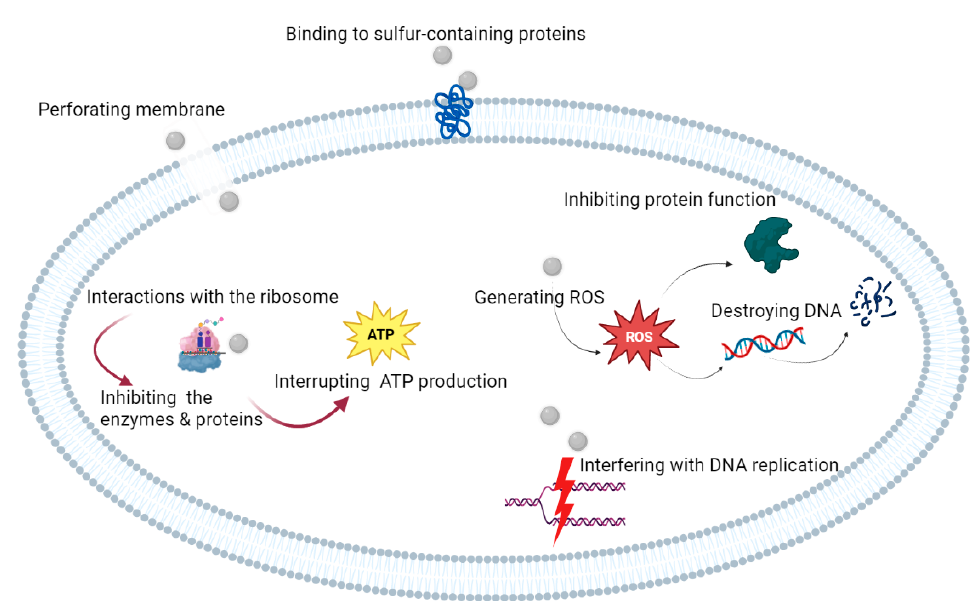
Figure 1. Biological activities of silver nanoparticles.